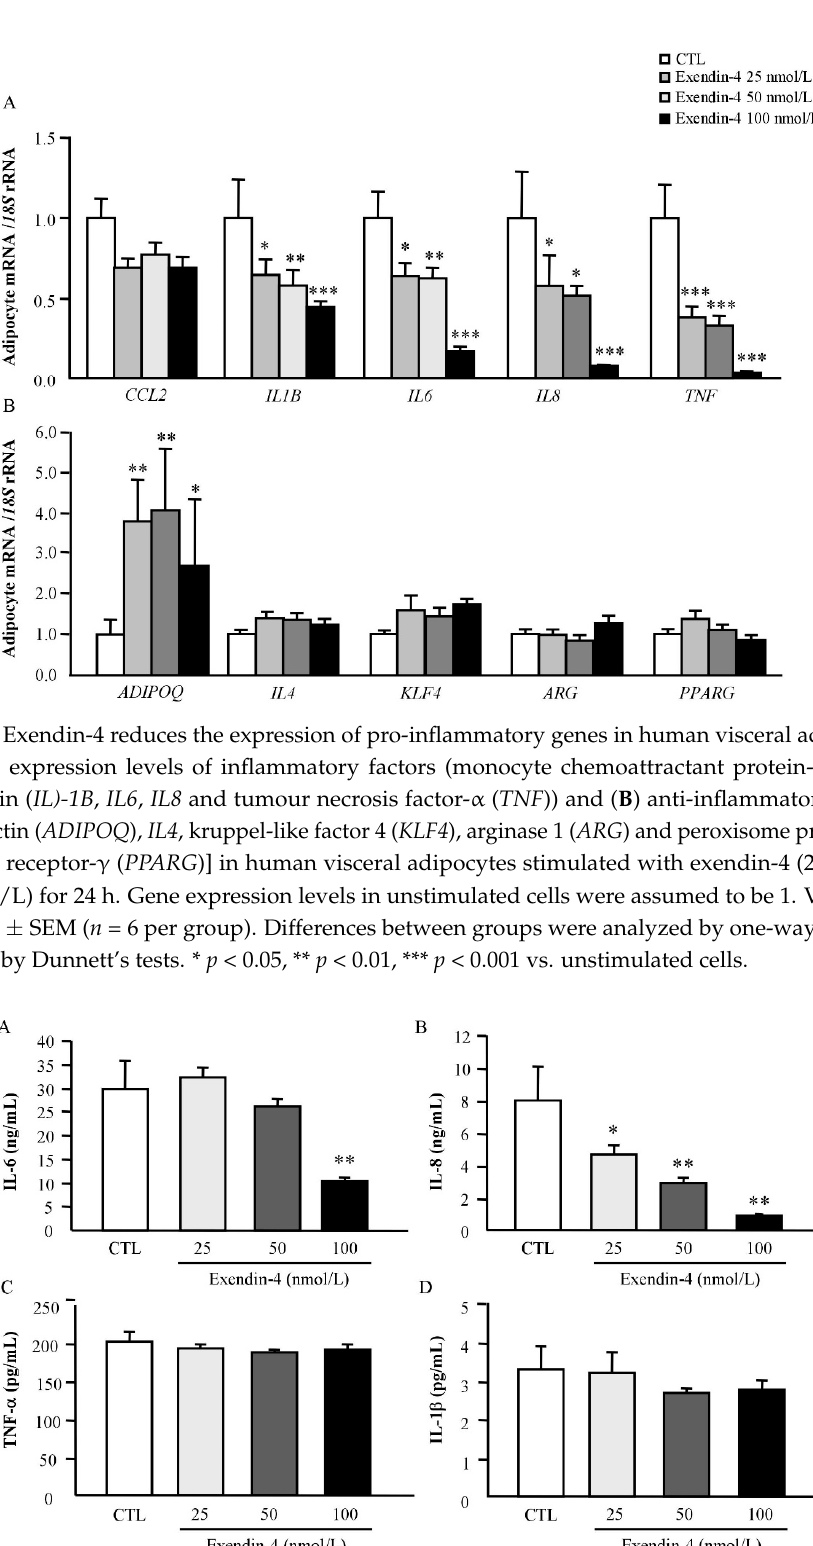
Figure 3. Secreted levels of main inflammatory markers after exendin-4 treatment. ( A ) Interleukin (IL)-6, ( B ) IL-8, ( C ) tumour necrosis factor (TNF)- α and ( D ) IL-1 β concentrations in the culture medium of human visceral adipocytes incubated in the presence (25, 50 and 100 nmol/L) or absence of exendin-4 for 24 h. Values are the mean ± SEM ( n = 6 per group). Differences between groups were analyzed by one-way ANOVA followed by Dunnett’s tests. * p < 0.05, ** p < 0.01 vs. unstimulated cells.